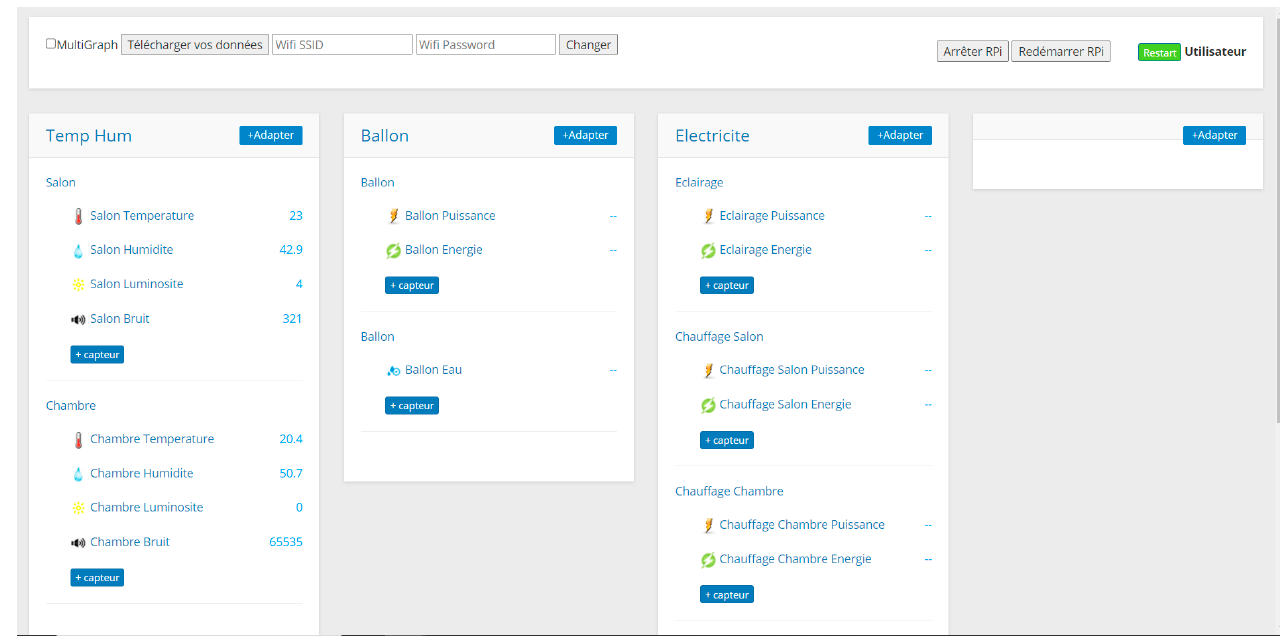
Figure 7. Manager’s interface.